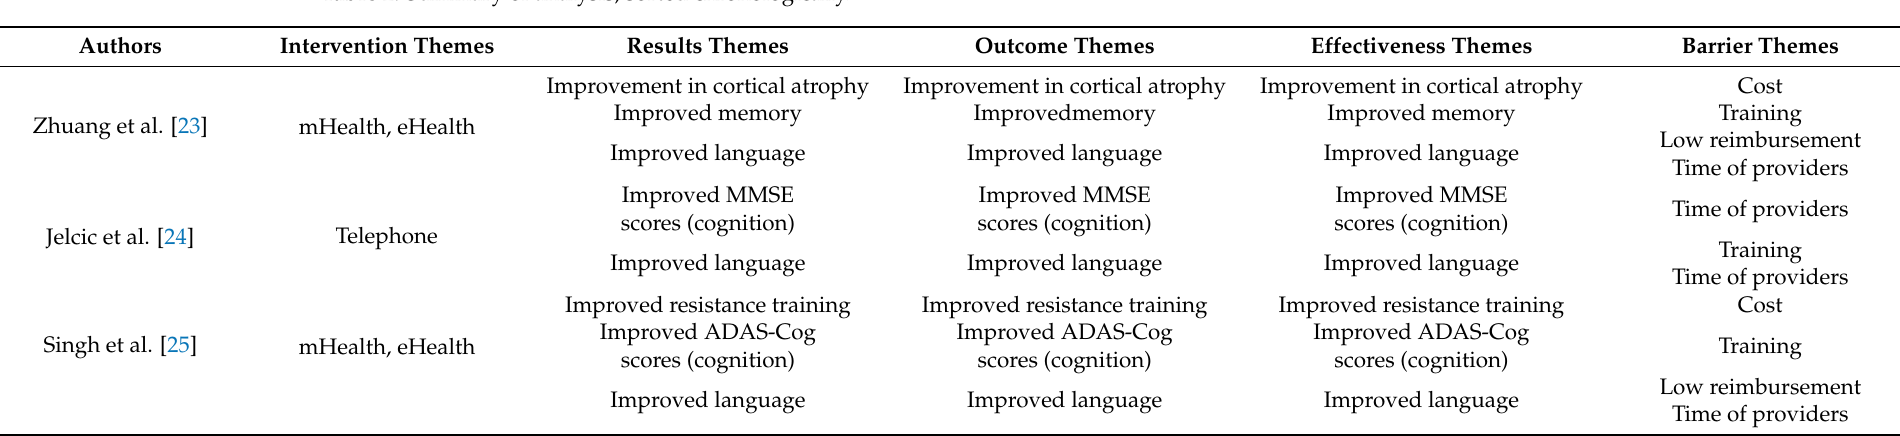
Table 2. Summary of analysis, sorted